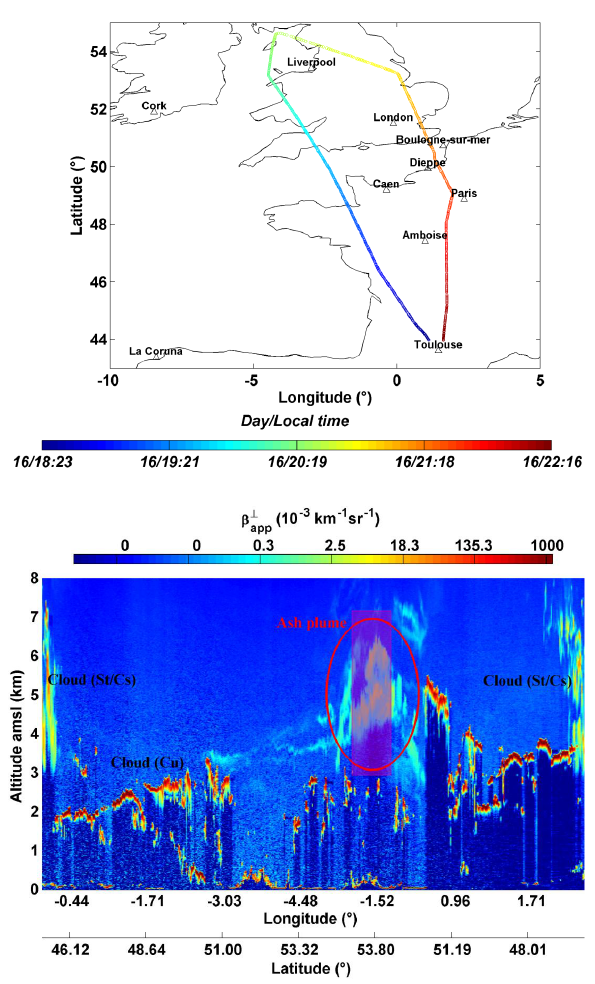
Figure 6: The same as Figure 4 for 16 May 2010, above UK. 600 Fig. 6. The same as Fig. 4 for 16 May 2010, above UK.